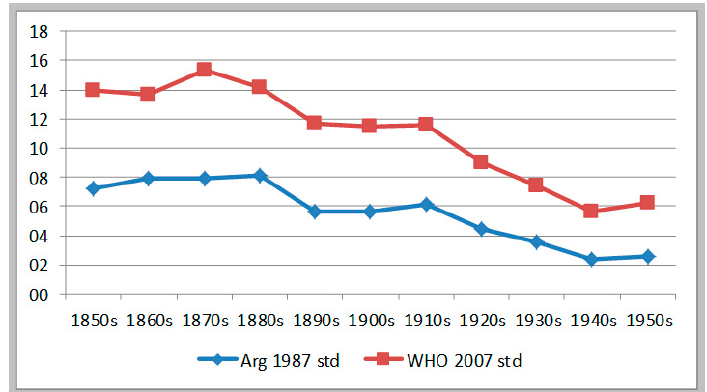
Figure 8. Moderate and severe stunting in the Pampa Region.